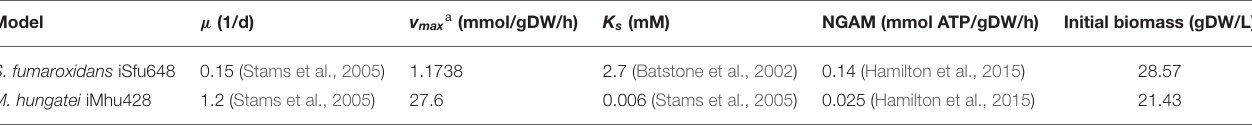
TABLE 2 | Model parameters and initial biomass concentrations for syntrophic co-culture simulation. Model